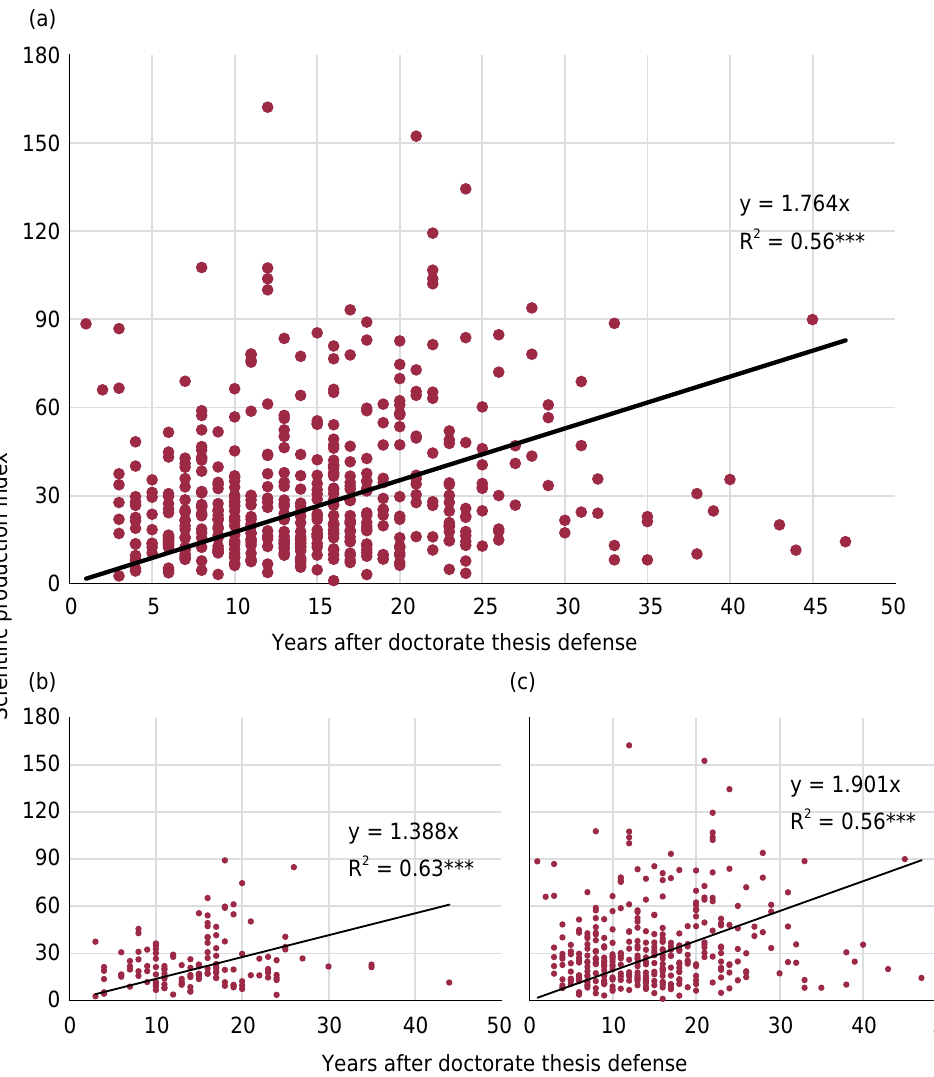
Figure 6. Scientific production index in the last five years (January 2013 to October 2018), as a function of the number of years after doctorate thesis defense, for all researchers regardless of gender (a) and by gender women (b) and men (c), in CNPq Call